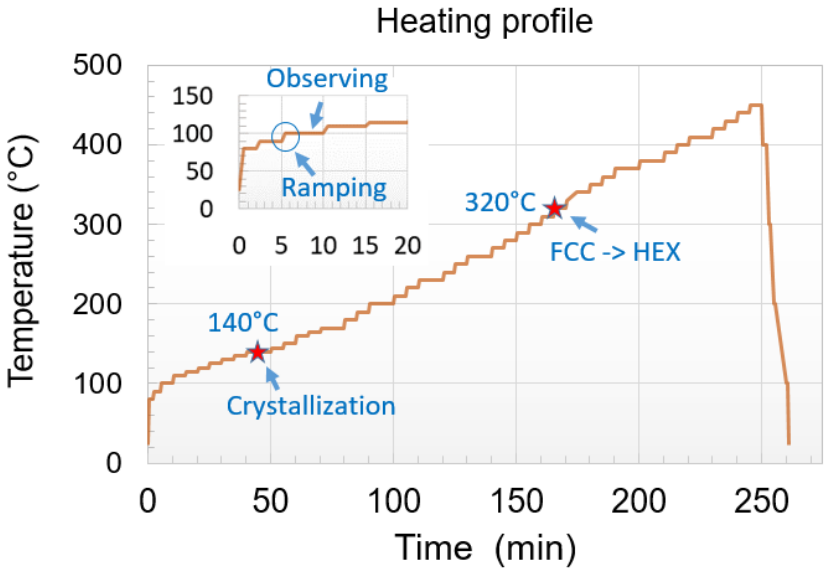
Figure 1. Typical heating profile used for in situ TEM annealing. The temperature was increased by steps of 5 °C from about 100 °C, using a ramping rate of 1 °C/s, and held for 5 min at this temperature during which the film was imaged (shown by the insertion). FCC to HEX refers to the transition from the face-centered cubic to the hexagonal phase.